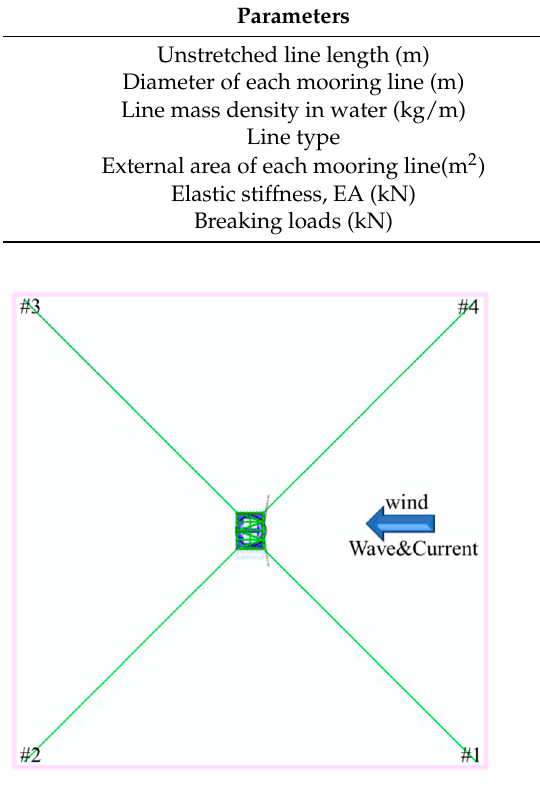
Figure 6. The schematic layout of mooring lines. Table 4. Properties of the mooring system.